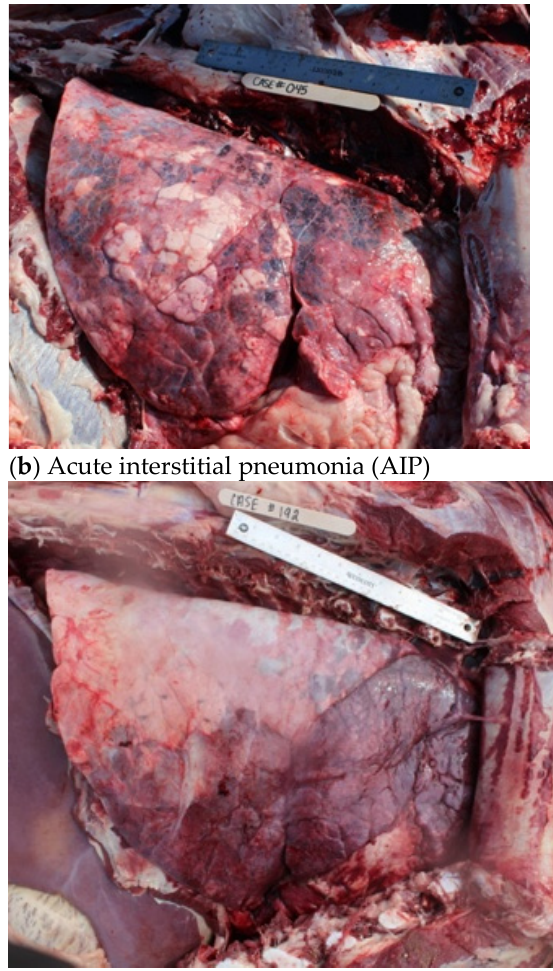
Figure 1. Right-sided view of gross lesion characteristics representing the three main gross pulmonary pathological diagnoses in this study: ( a ) bronchopneumonia (BP), ( b ) acute interstitial pneumonia (AIP), and ( c ) bronchopneumonia with an interstitial pneumonia